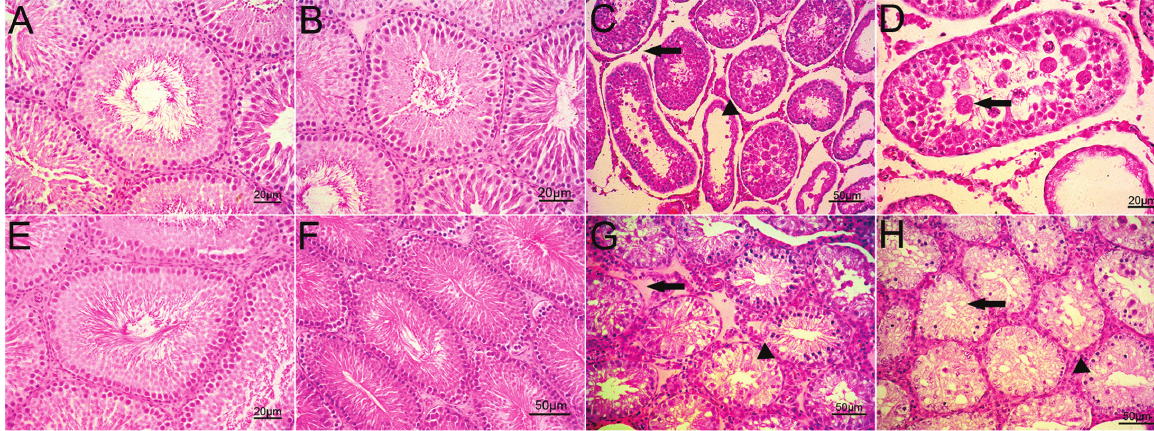
Figure 1. Histopathological analysis of rat testes with HE staining by light microscopy. A , E , The normal structure of rat testes in the control group for 7 and 14 days, respectively. B , F, The morphology of rat testes of the tail traction group for 7 and 14 days, respectively. C , In the 7-day tail suspension group, the testicular tubules were arranged sparsely (arrow) with degeneration and necrosis of the spermatogenic cells (arrowhead). D , In the 7-day tail suspension group, the spermatogenic cells of the seminiferous tubules became loose, sparse and disorderly, with the formation of a syncytial structure (arrow). G , In the 14-day tail suspension group, protein fluid exudations (arrow) were conspicuously present in interstitial tissue and all germ cells had disappeared (arrowhead). H , In the 14-day tail suspension group, all germ cells had disappeared, with only a small number of residue and seminoma cells (arrow) being left; also, obvious fibroplasia was observed in interstitial tissue